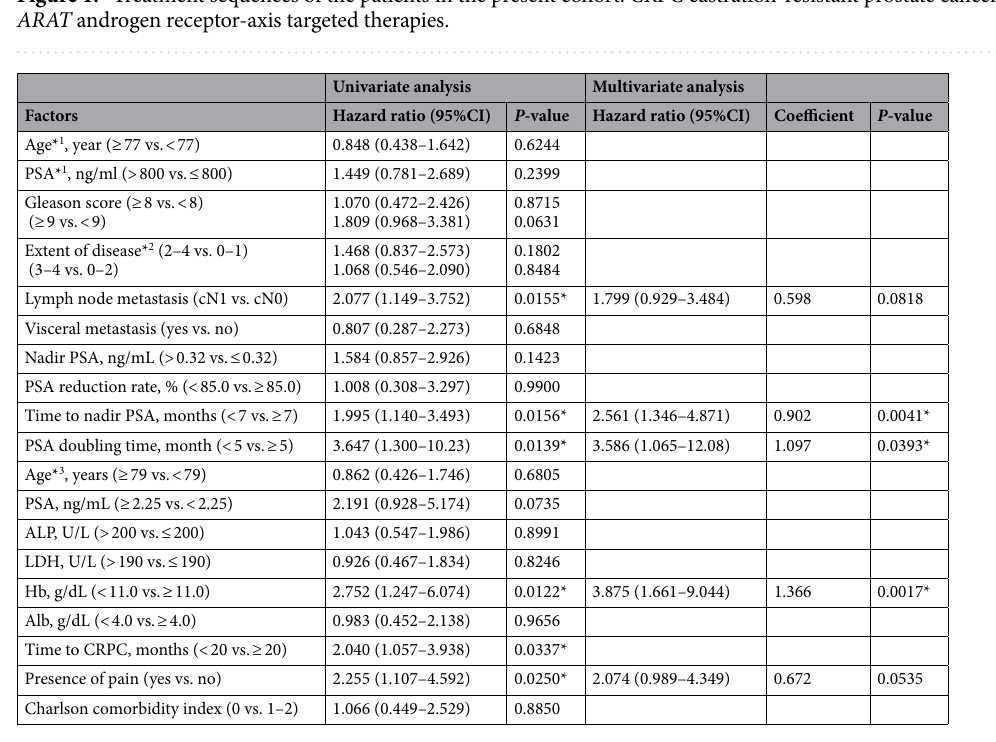
Table 2. Univariate and multivariate analysis of prognostic factors of overall survival. CI confidence interval; PSA prostate-specific antigen; ALP alkaline phosphatase; LDH lactate dehydrogenase; Hb Hemoglobin; Alb Albumin; CRPC castration-resistant prostate cancer. *Statistically significant with a P < 0.05. * 1 At prostate cancer diagnosis. * 2 Extent of disease is defined by a number of bone metastases. * 3 At CRPC